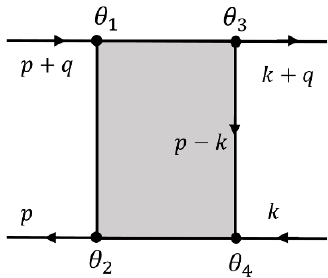
Figure 5. The leading order four-point